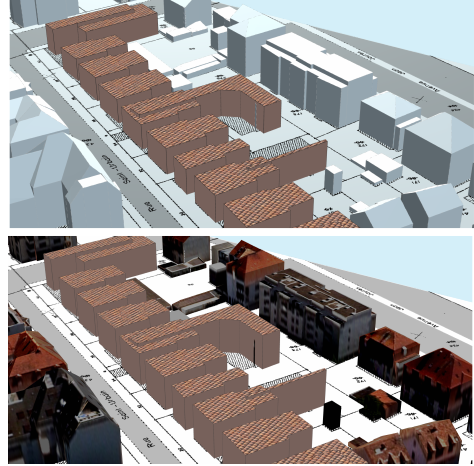
Figure 9. Mix style for the focus and various contexts. upper image: discreet context; lower image: photo-realist